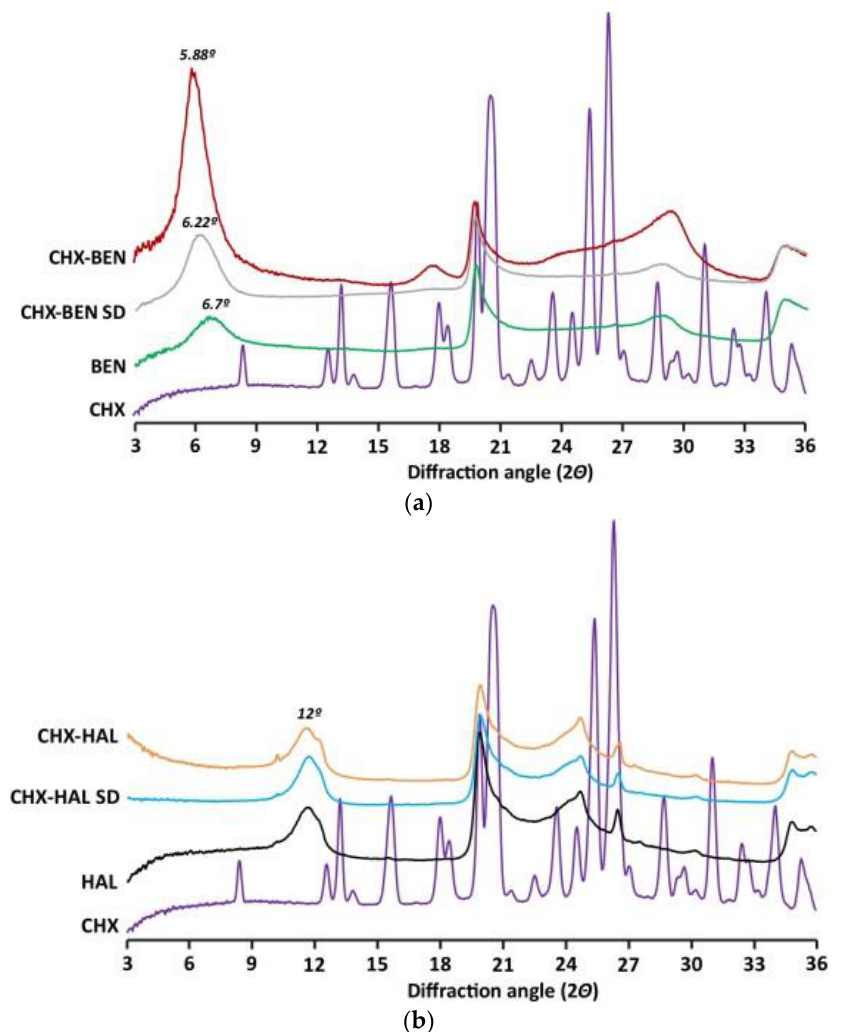
Figure 2. XRPD patterns of nanohybrids and pristine components: ( a ) BEN-based nanohybrids; ( b ) HAL-based nanohybrids. CHX: chlorhexidine dihydrochloride; BEN: bentonite; HAL: